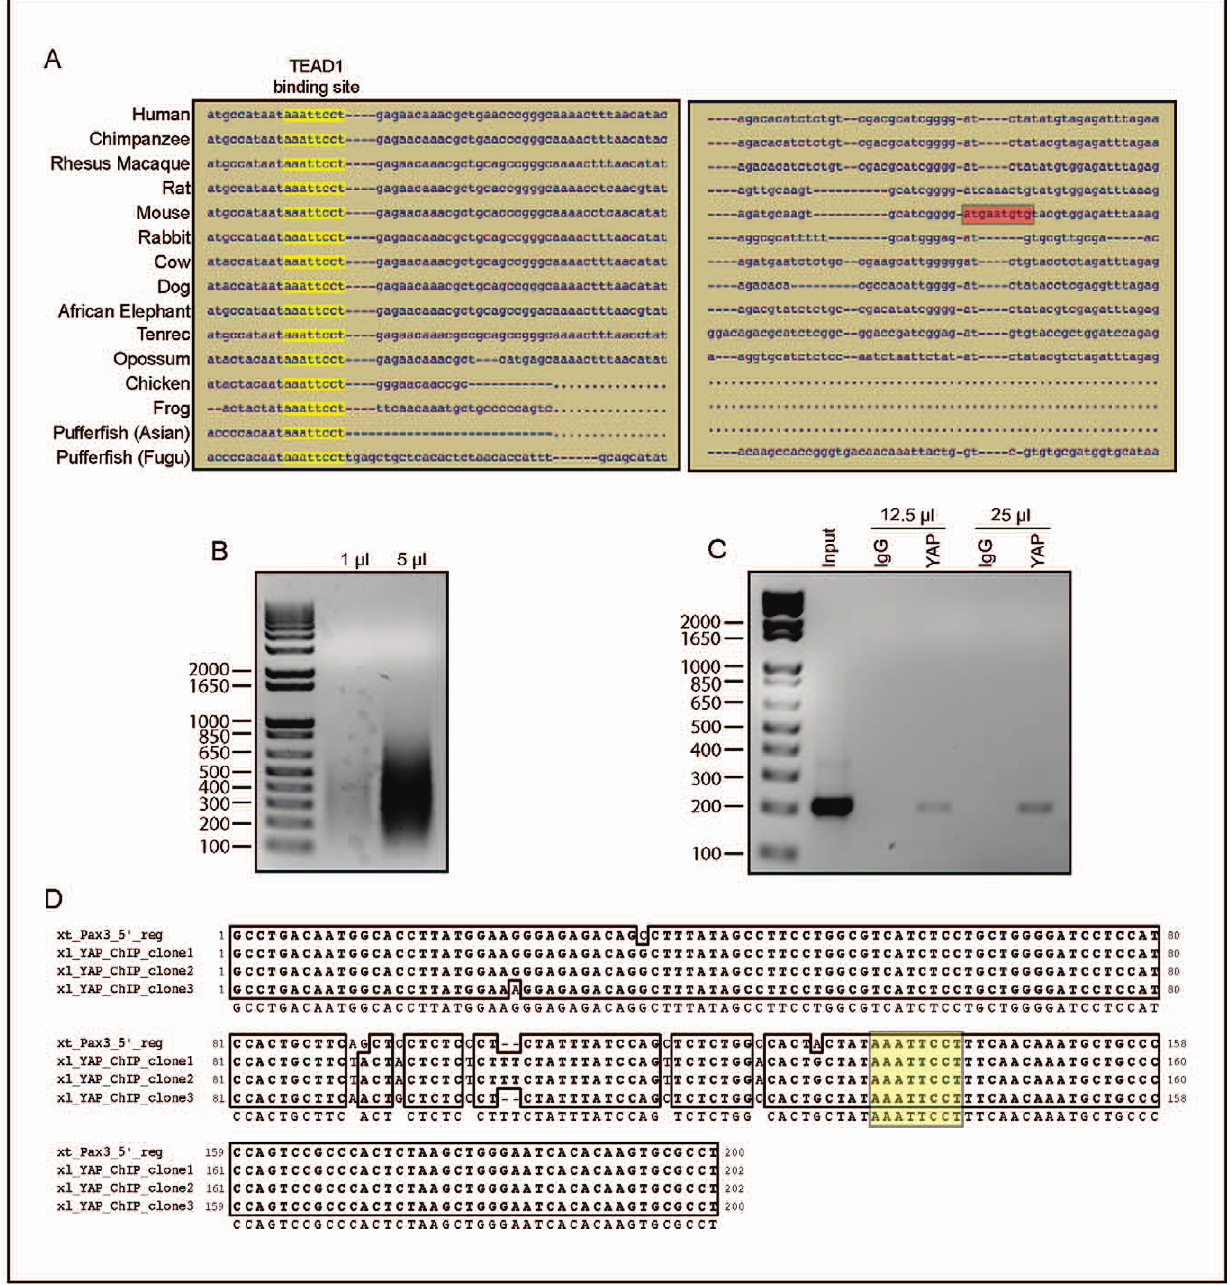
Figure 7. Endogenous xYAP resides at a novel 5 9 regulatory region of pax3 . ( A ) A highly conserved putative TEAD-binding site (yellow boxes) is present in the 5 9 regulatory region of the pax3 gene in 15 different vertebrates. A previously described mouse TEAD-binding site (red box) appears less conserved. ( B ) Chromatin isolated from 300 wild type stage 14–16 Xenopus laevis embryos was sheared to a size range of 150 to 900 base pairs. ( C ) Chromatin immunoprecipitations (ChIPs) from 12.5 m g or 25 m g of sheared chromatin immunoprecipitated a band at the expected size for the putative novel TEAD1-binding site region with the hYAP antibody but not with a control IgG antibody. ( D ) Sequencing of this band from three different clones verified that the genomic region pulled down by the hYAP anitbody contained the novel TEAD-binding site (yellow) when compared to the Xenopus tropicalis genomic sequence.